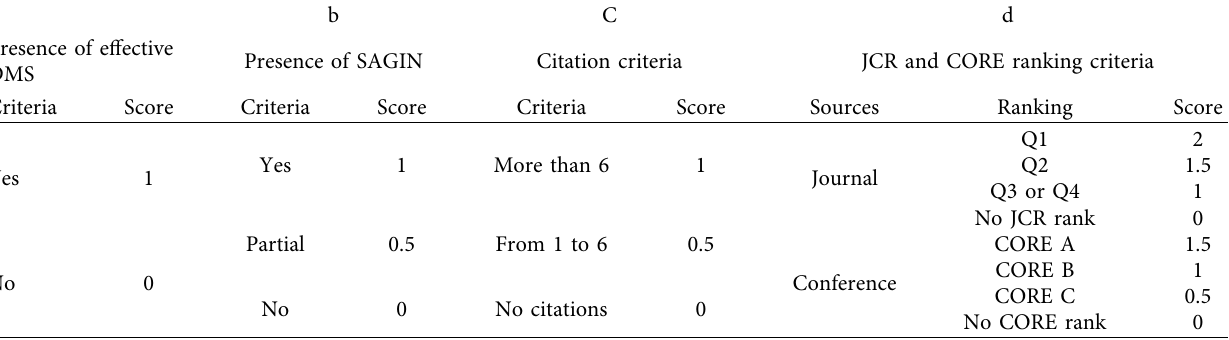
Table 4: Quality assessment criteria.